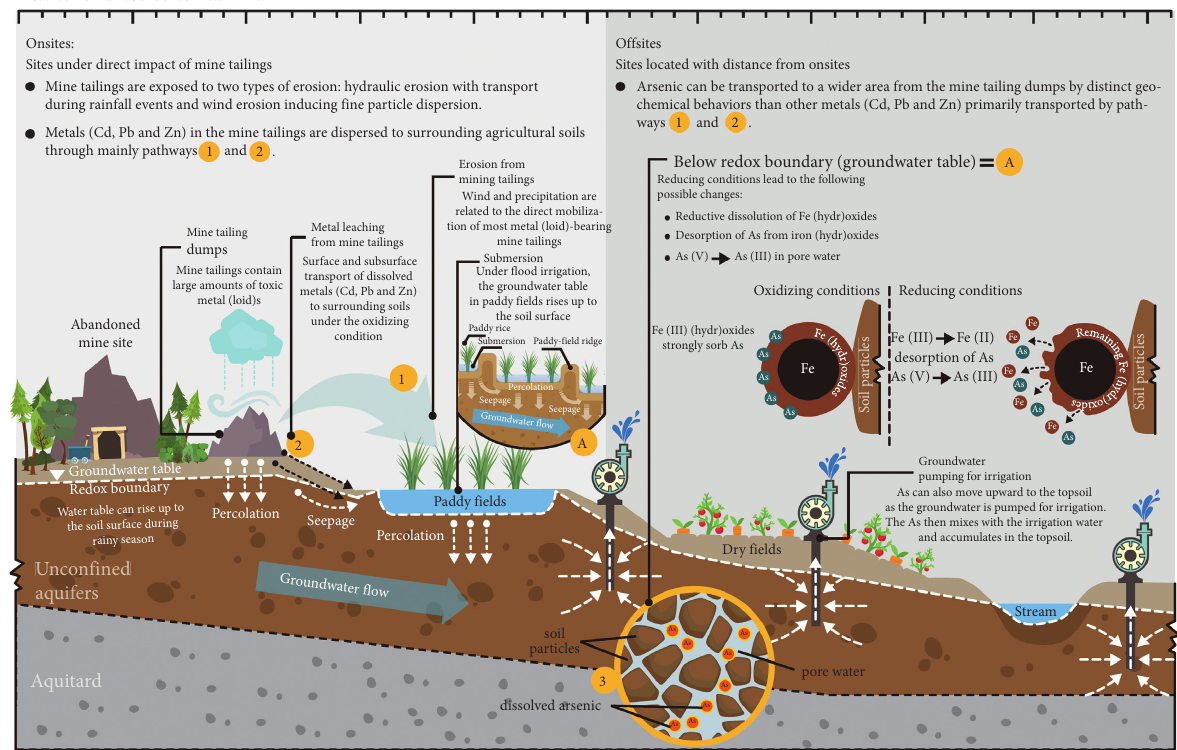
Figure 6: Conceptual diagram illustrating the transport processes of metal(loid)s from the mine tailing dumps to the surrounding ag- ricultural soils in the study